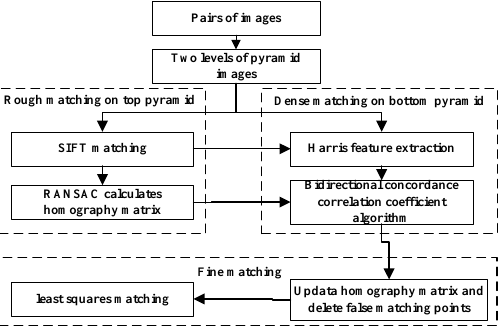
Figure 7. Image matching